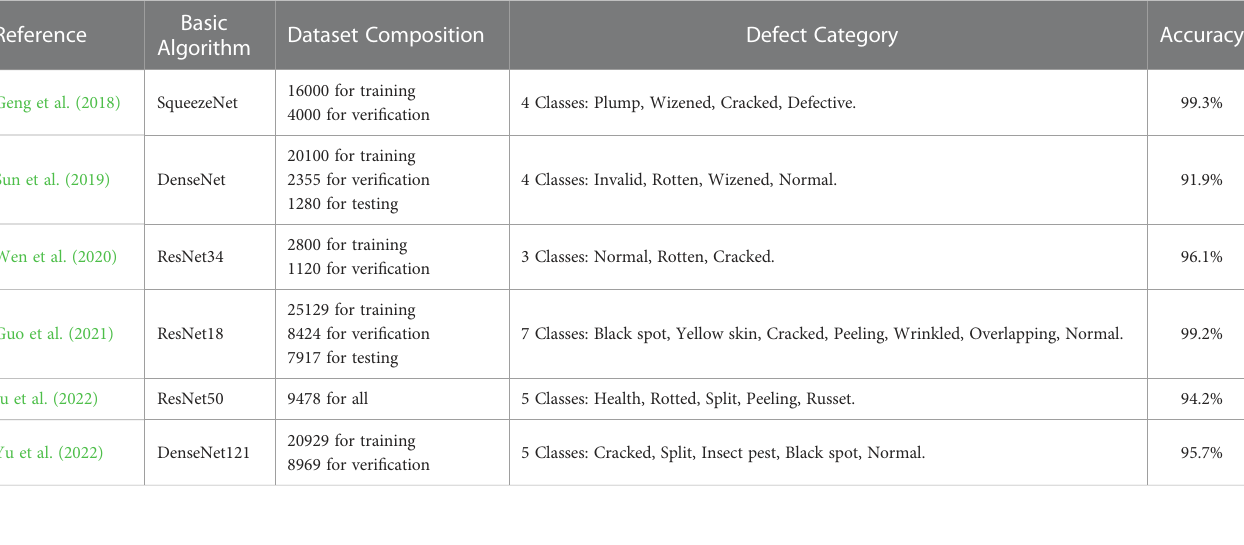
TABLE 2 Experimental results of algorithms in their own datasets in the relevant literature.